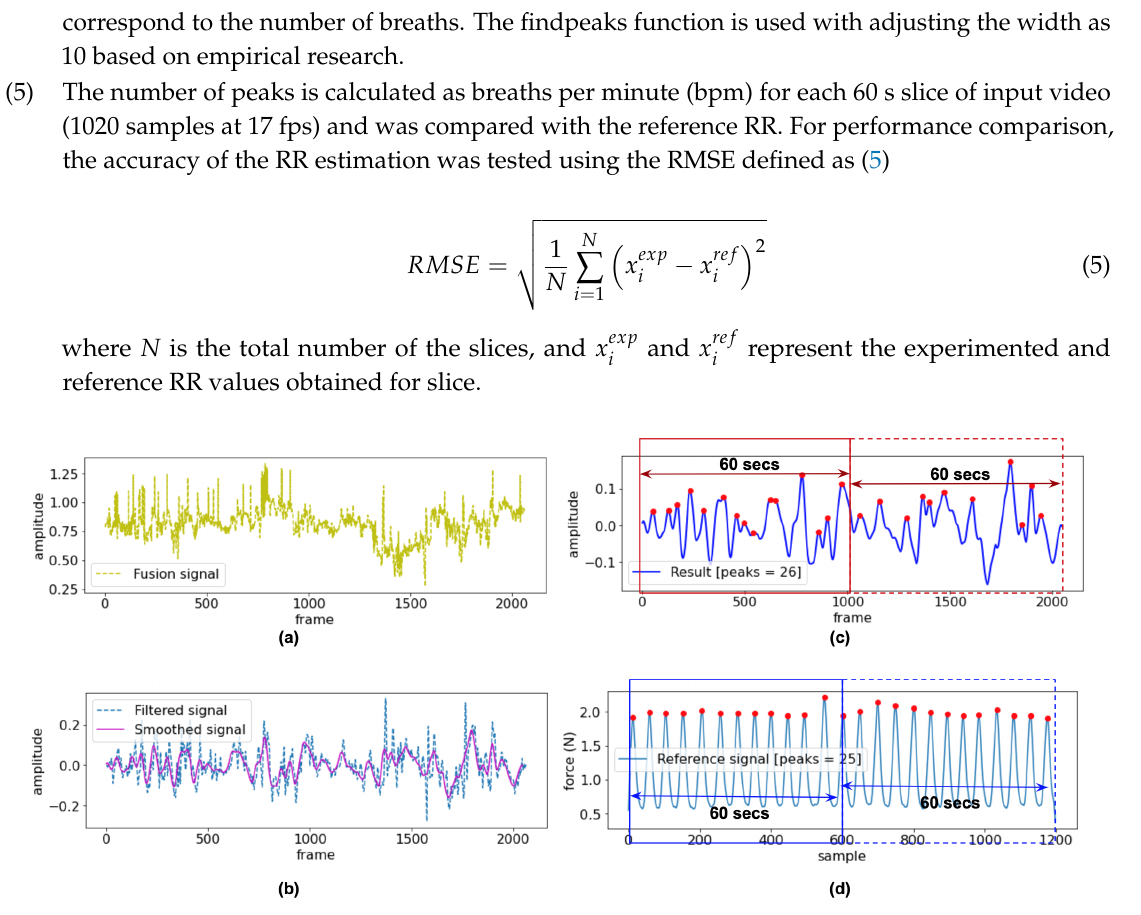
Figure 4. ( a ) Sample of fusion signal, ( b ) filtered and smoothed signals, ( c ) peak detection of experiment signal, and ( d ) peak detection of the reference